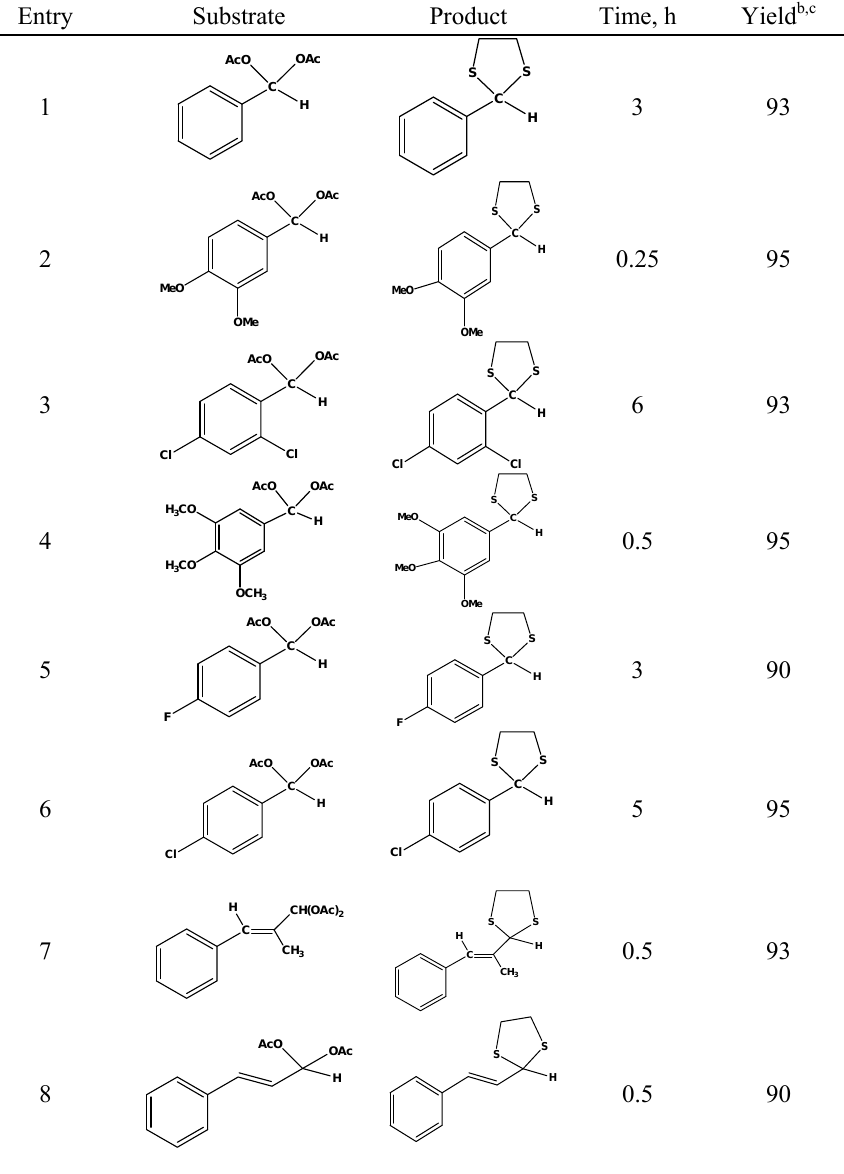
Yield b,c Time, h Product Substrate